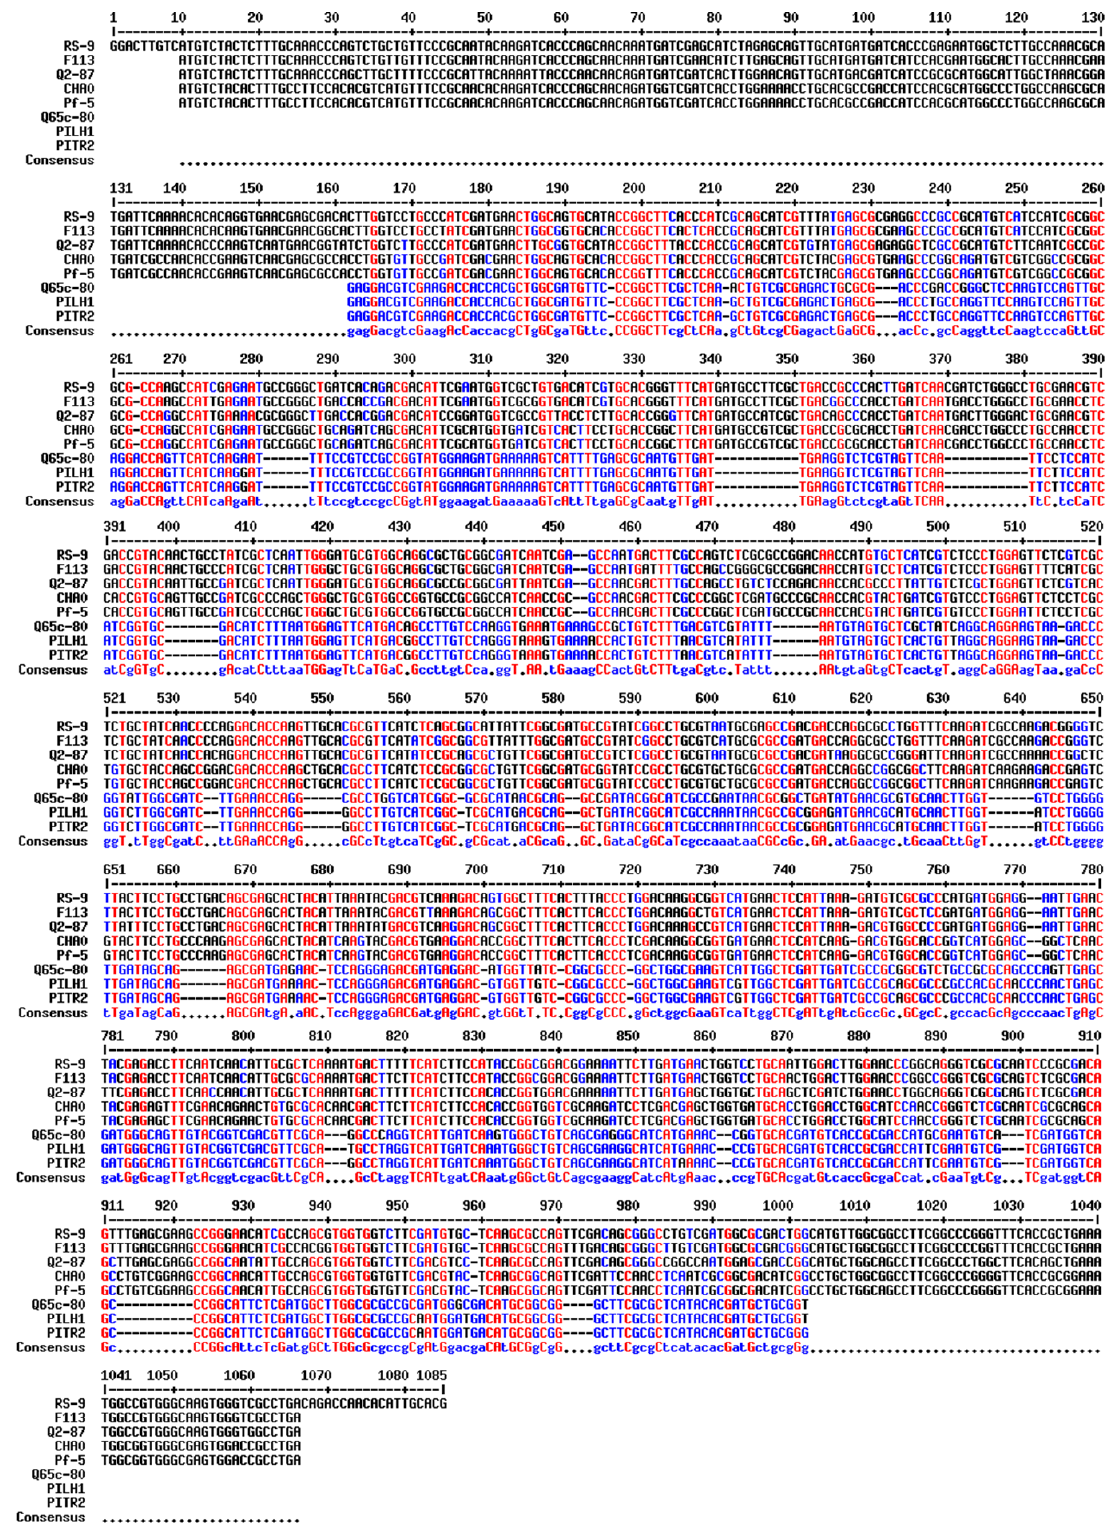
Figure 5. Pairwise sequence alignment of the cloned phl D gene (RS-9) with the reported DAPG producing phl D gene from Pseudomonas strains from the database (http://multalin.toulouse.inra.fr/ multalin/, accessed on 15 March 2022). Our cloned phl D gene from the RS-9 strain showed homology with already reported phl D genes from Pseudomonas strain F113, Q2-87, CHAO, Pf-5, Q65c-80, PILH1, and